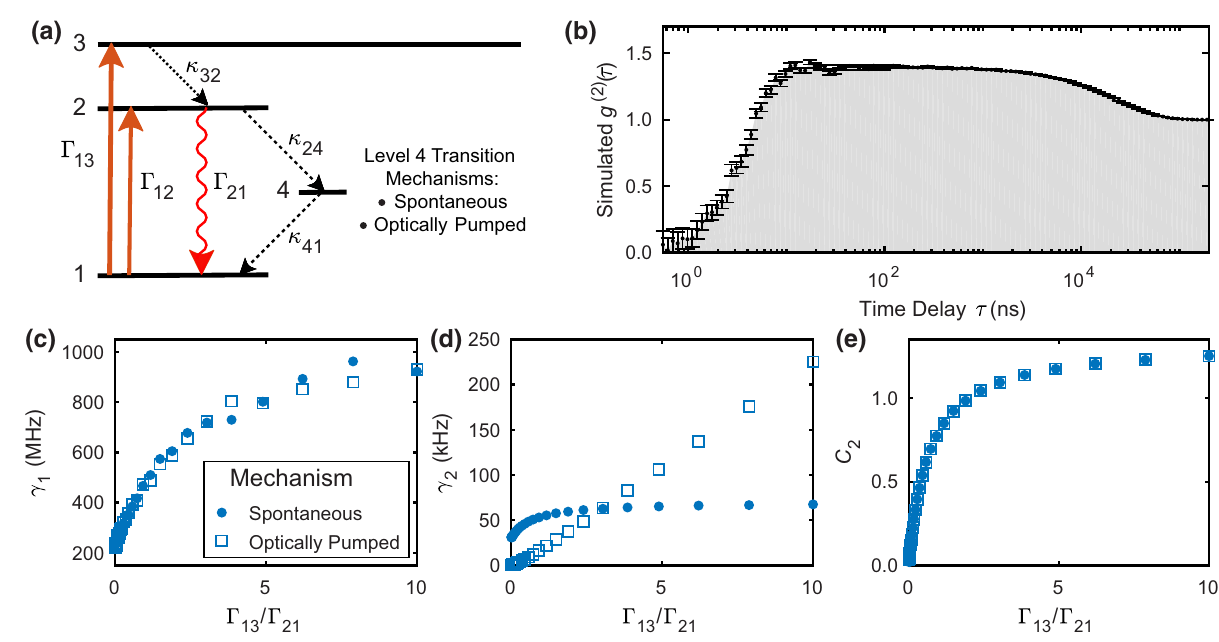
FIG. 6. Electronic level structure and optical dynamics simulations. (a) An investigative four-level electronic model consisting of the ground state (level 1), radiative state (level 2), excited state (level 3), and metastable state (level 4). Orange arrows represent excitation pathways (with rates (cid:8) 12 and (cid:8) 13 ) , the wavy red arrow represents radiative emission (with rate (cid:8) 21 ), and dotted black arrows represent nonradiative transitions (with rates κ 32 , κ 24 , and κ 41 ). (b) Simulated g ( 2 ) (τ) for (cid:8) 12 = 0, (cid:8) 13 = 84 MHz, (cid:8) 21 = 300 MHz, = 600 MHz, κ = 60 kHz, and κ = 30 kHz. Error bars represent simulated photon shot noise. (c)–(e) Best-fit parameters γ κ 32 24 41 and C 2 determined by fitting simulated g ( 2 ) (τ) data using Eq. (5) with n = 2. The results are plotted as a function of (cid:8) 13 /(cid:8) 21 , where = 300 MHz is a fixed (cid:8) 21